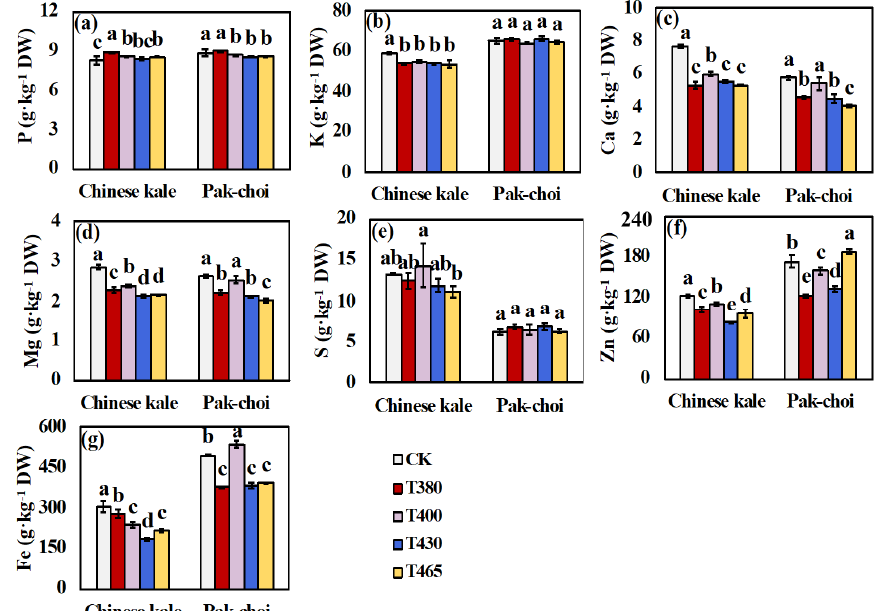
Figure 4. Minerals of two baby-leaves under di ff erent wavebands of blue and UV-A light. The contents of ( a ) P = phosphorous, ( b ) K = potassium, ( c ) Ca = calcium, ( d ) Mg = magnesium, ( e ) S = sulphur, ( f ) Zn = zinc, and ( g ) Fe = iron. Di ff erent letters (a–e) upon the bar plots indicate significant di ff erence at p < 0.05 using one-way analysis of variance with Duncan’s multiple-range